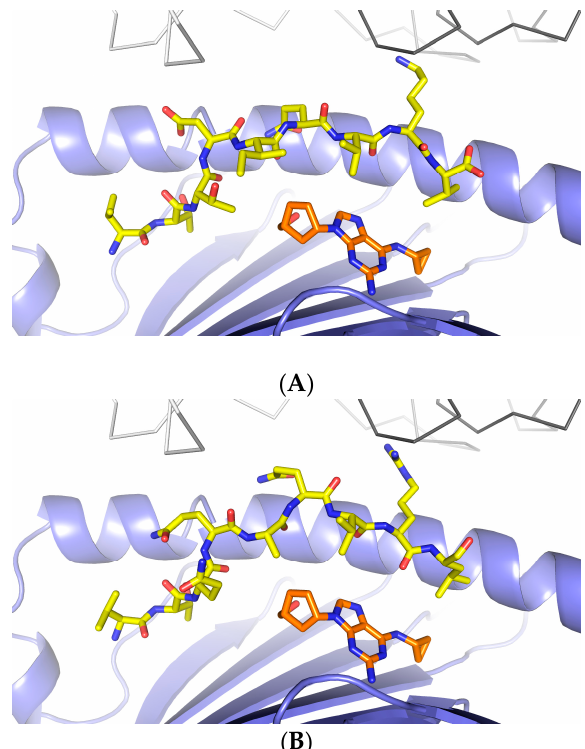
Figure 3. Structural similarity between self and viral peptides that bind abacavir in the context of HLA-B*57:01. ( A ) shows the crystal structure of the VTTDIQVKV SPT5a 976-984/abacavir/HLA-B*57:01 complex. ( B ) shows a model of VTQQAQVRL, corresponding to HSV1/2 230-238, complexed to abacavir and HLA-B*57:01. The HLA-B restricted TCR (gray lines) from 2NX5 was superimposed on HLA-B*57:01.